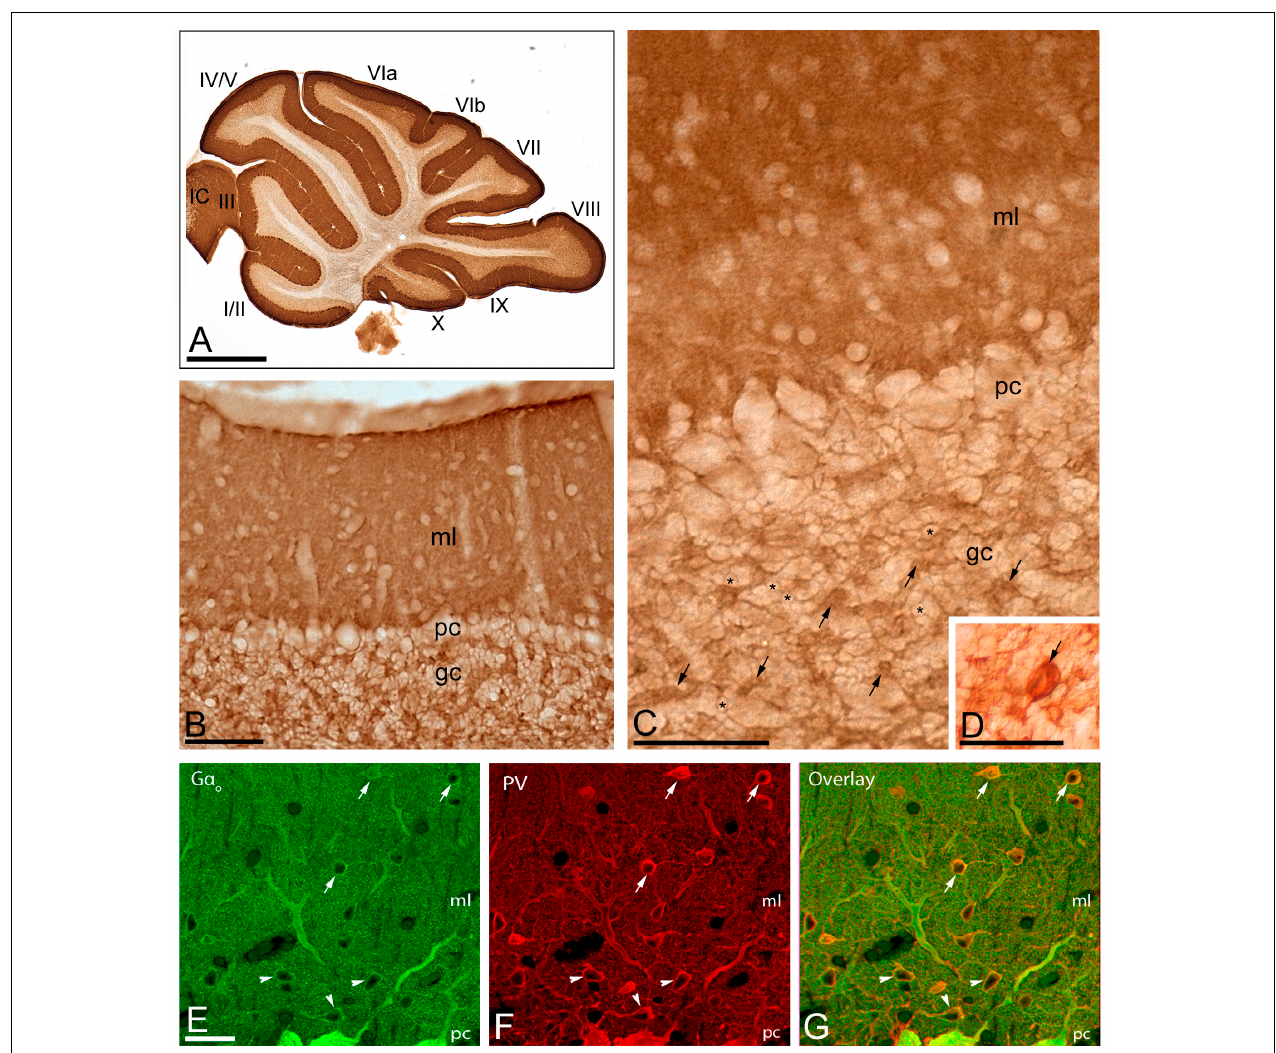
FIGURE 2 | Regional and cellular distribution of G α o in the cerebellum. (A–D) Immunoreactivity for G α o in the cerebellar cortex using an immunoperoxidase method. The parasagittal photomicrography of the cerebellum [panel (A) ] shows strong immunolabeling for G α o in the molecular layer (ml), in somata of PCs in the Purkinje cell layer (pc) and moderate in the granule cell layer (gc), with similar distribution pattern and expression levels in all cerebellar lobules (lobules I to X). Immunoreactivity for G α o was detected in the neuropil of the molecular layer, but outlined granule cells (example, asterisks), and labeled glomeruli (example, arrows) and Golgi cells [arrow in panel (D) ]. IC: inferior colliculus. (E–G) Co-localization of G α o with Parvalbumin (PV) in basket cells (arrowheads) and stellate cells (arrows) using double-labeling immunofluorescence visualized with scanning confocal microscopy. Confocal images of the cerebellar cortex showing immunofluorescent labeling for G α o (left, green) and PV (middle, red) and their colocalization in the overlay image (right). Abbreviations : ml, molecular layer; pc, Purkinje cell layer; gc, granule cell layer. Scale bars: (A) 1 mm; (B–D) 10 µ m; (E–G) 20 µ